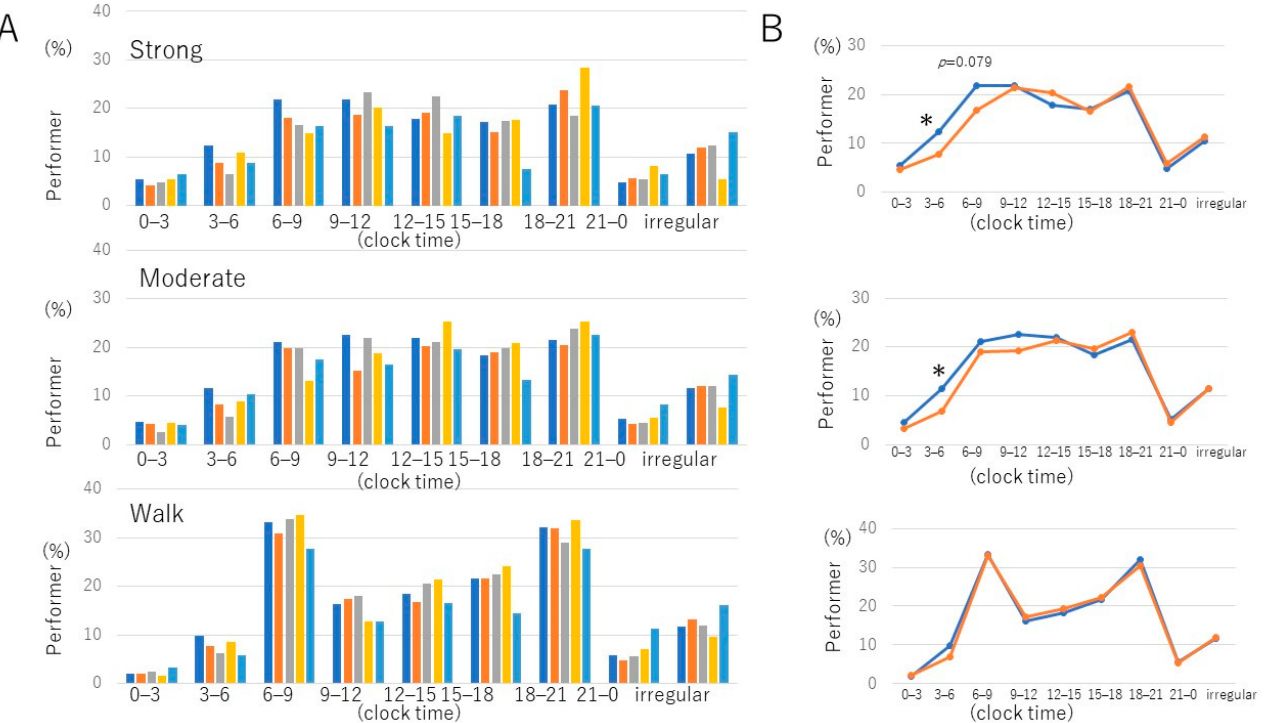
Figure 2. Performer percentage to each exercise at different time points. ( A ) Percentage of performers for each breakfast (BF) style. The left-to-right columns are the Japanese, Japanese/Western, Western, cereal, and skipping breakfast groups. ( B ) Daily rhythm of performer percentage in Japanese BF (blue line) and other BF (orange line), including the J-W, western, and cereal groups. * p < 0.05, Fisher’s exact probability test vs. other BF groups. Irregular refers to exercise without specific time points.